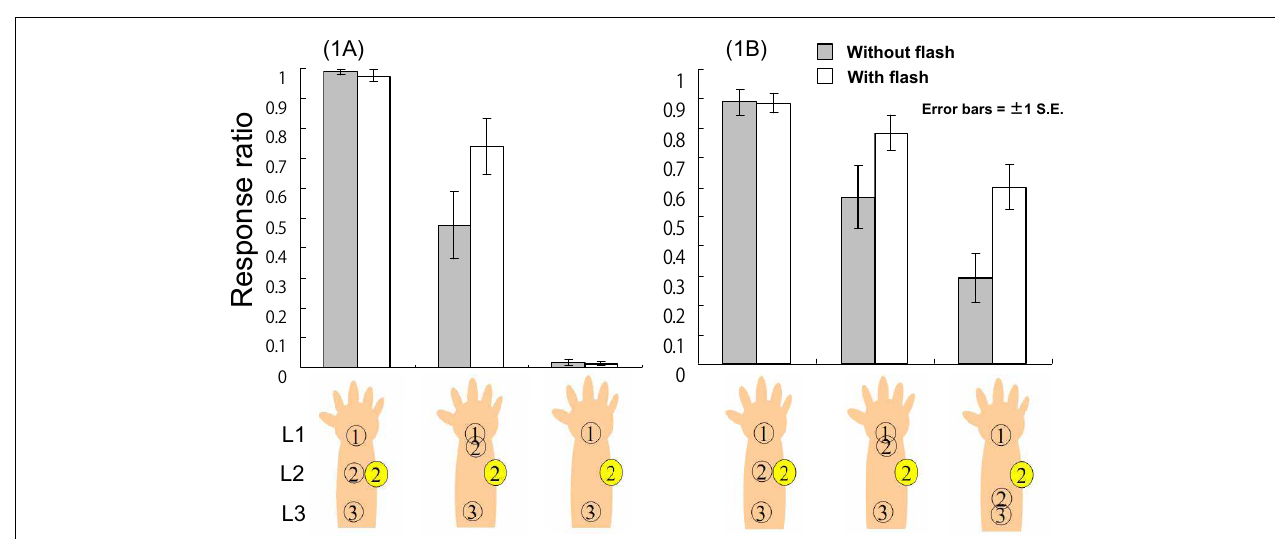
FIGURE 2 |The response ratio (L1–L2–L3 tactile feeling) in Experiment 1A and B. Note:The numbers in circles mean the timings 1 (cid:13) corresponds to t 1. For example, the leftmost illustration means that L1 → L2 → L3 tactile stimuli with flash at t 2 timing.